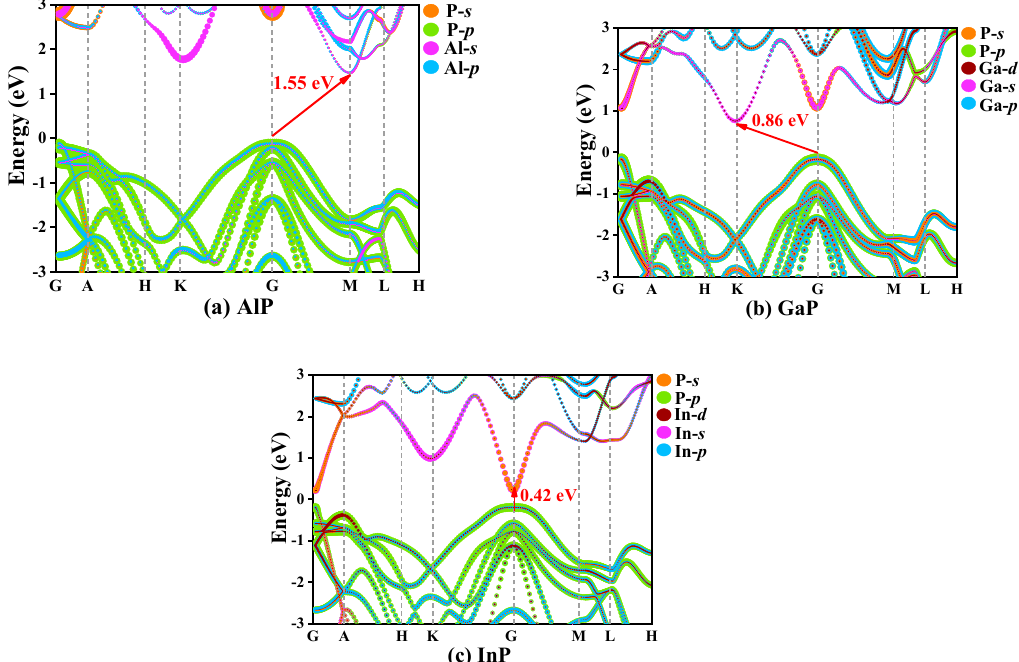
Figure 7. The electronic band structure for P 6 4 22- X P ( X = Al, Ga, or In), AlP ( a ), GaP ( b ), InP ( c ).